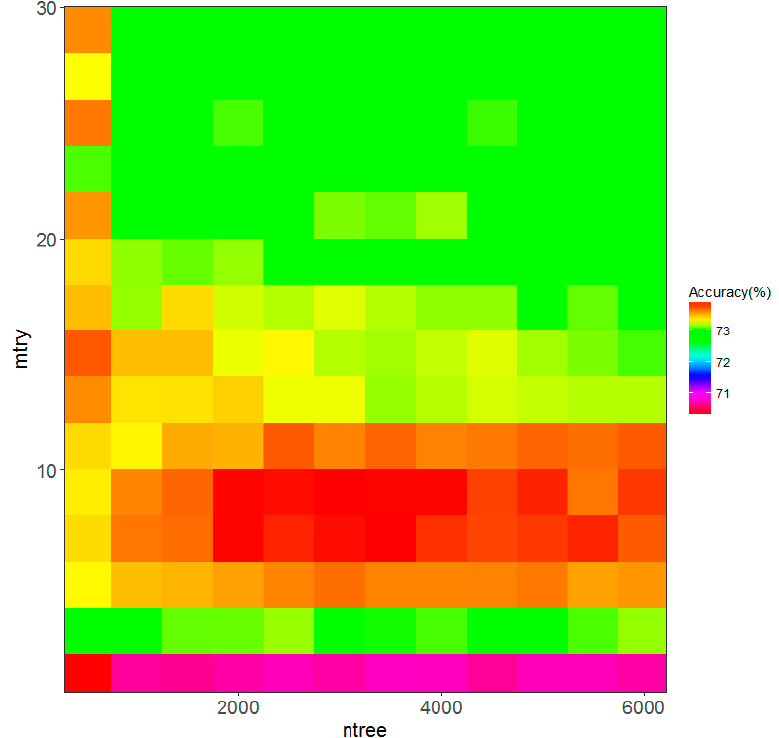
Figure 3. The matrix of mean validation accuracy with different combinations of mtry and ntree values.